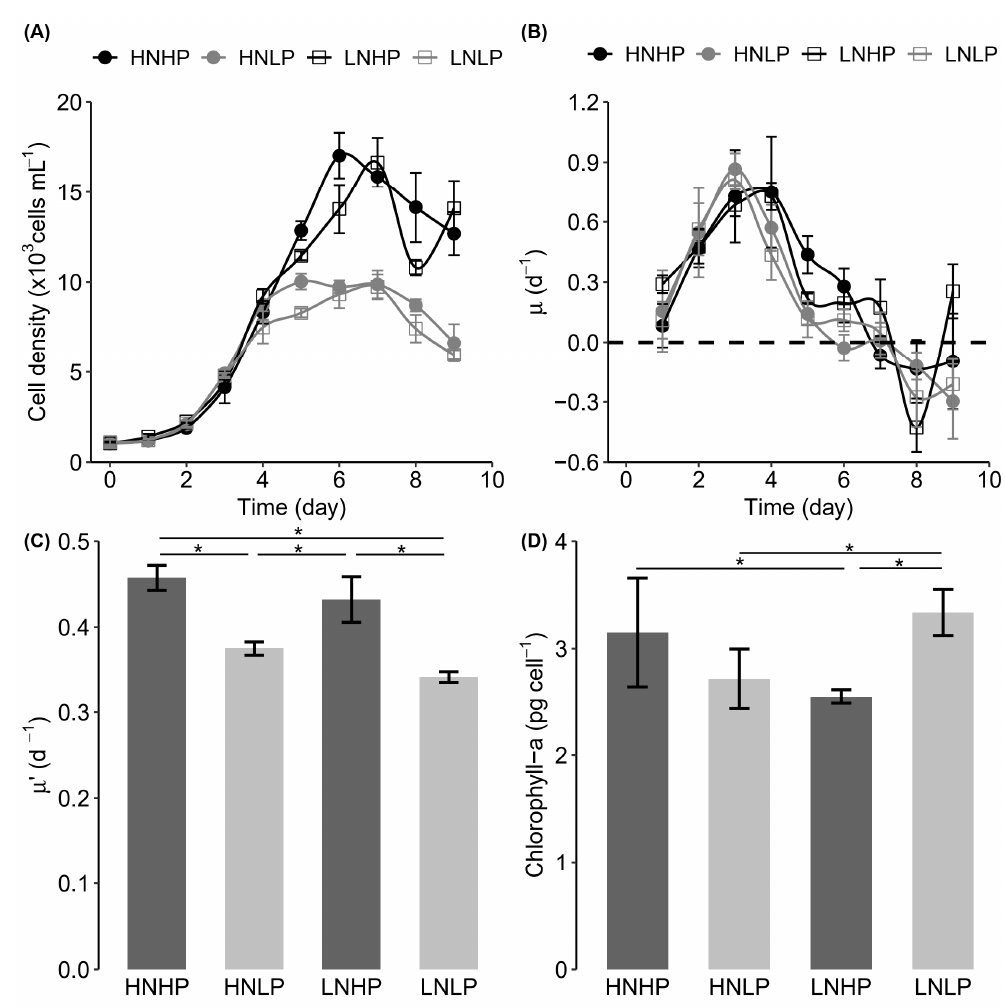
Figure 1. Growth and chlorophyll-a response of Heterosigma akashiwo in the four nutrient scenarios: ( A ) Changes in cell density (cells mL − 1 ); ( B ) Daily specific growth rate µ with time (d − 1 ); ( C ) Specific growth rate in the exponential growth phase µ (cid:48) (d − 1 ); ( D ) Cellular chlorophyll-a concentration (pg cell − 1 ). The error bar represents the standard error (number of samples = 3); The asterisk indicates significant differences ( p < 0.05) across scenarios.